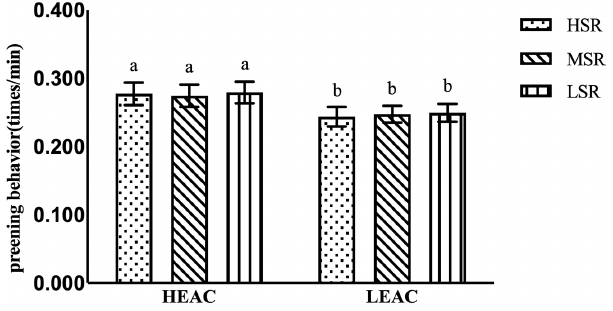
Figure 3. Effects of hen’s social ranking order (SRO) on preening be- havior in high and low enrichments allocation cages (HEAC and LEAC). a,b